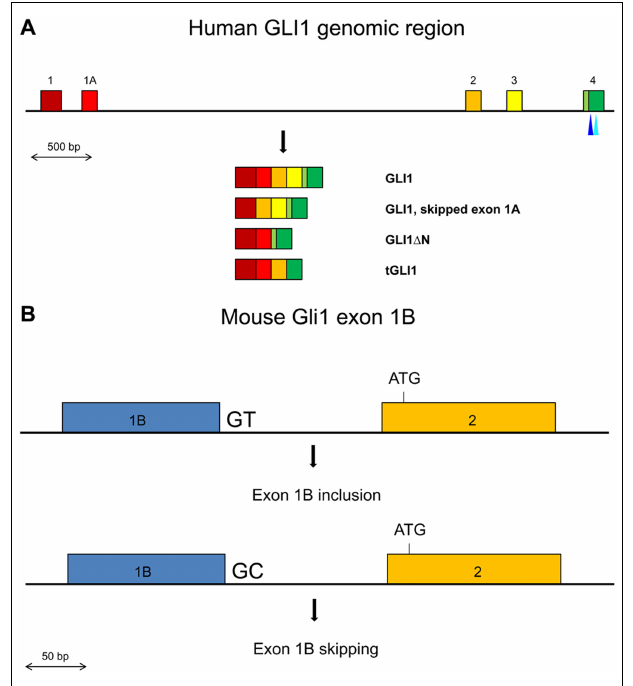
FIGURE 1 | (A) Schematic representation of the exons 1 to 4 region in the human GLI1 gene. Exons are shown by colored boxes.The GLI1 mRNA variants are indicated.The canonical translation initiation codon is present in exon 2. In GLI1 (cid:2) N, skipping of exons 2 and 3 results in the use of a methionine codon in exon 4 as the initiator. In tGLI1, skipping of exon 3 and partially exon 4 does not alter the translational reading frame.The positions of the SNPs in exon 4 that may affect exon skipping or generate an ectopic splice site are indicated by light and dark blue triangles respectively. (B) Schematic representation of the Gli1 exon 1B inclusion/skipping in the mouse. BALB/c mice contain the conserved GT dinucleotide at the exon 1B/intron 1B junction resulting in exon 1B being mostly included in the Gli1 mRNAs. C57BL/6 mice contain a GC dinucleotide at the exon 1B/intron 1B junction resulting in exon 1B being mostly skipped in the Gli1